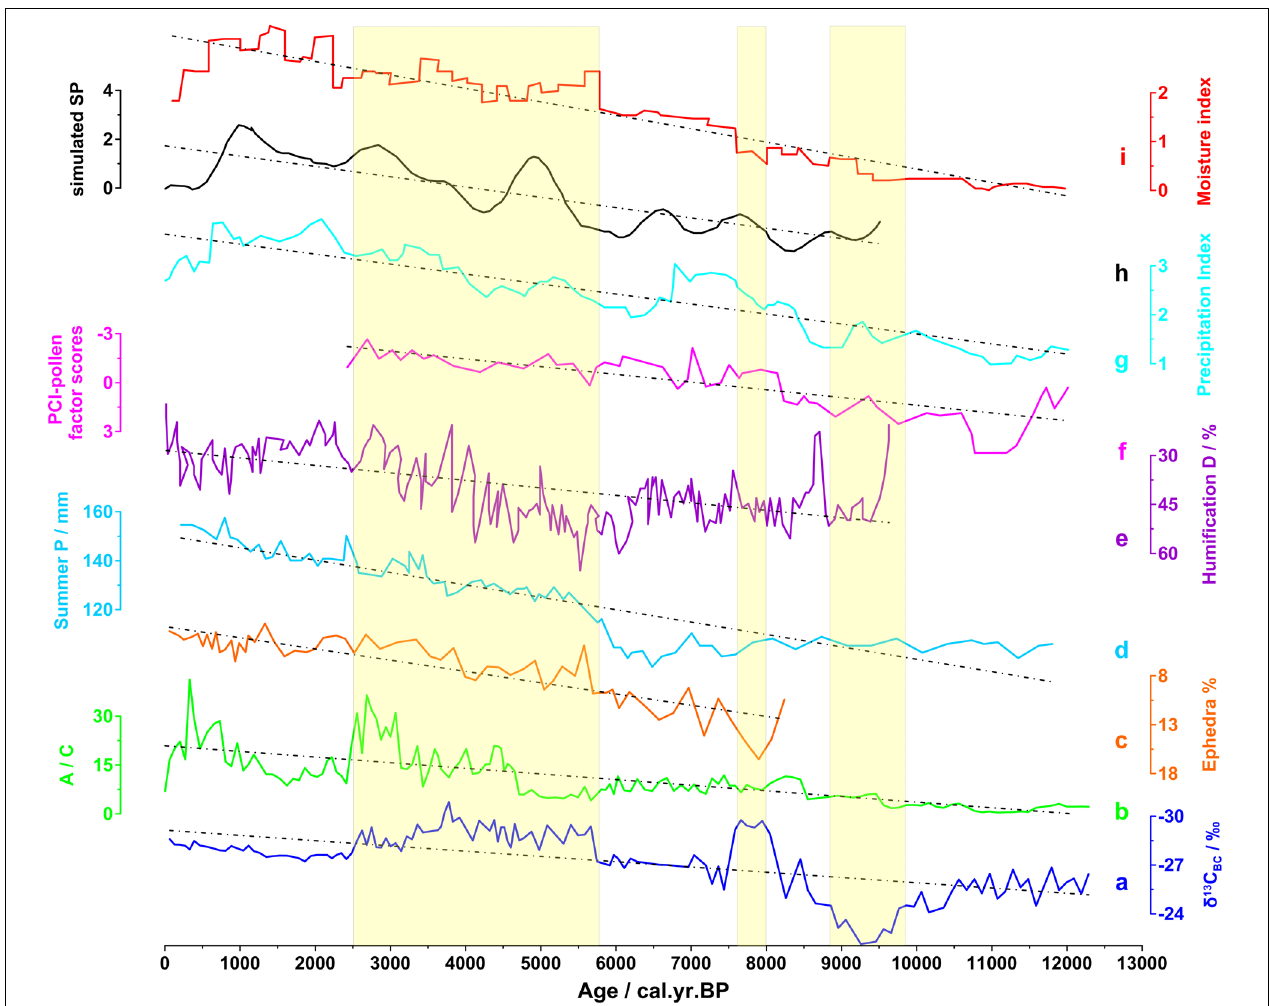
FIGURE 2 | Comparisons between a BC carbon isotope record of Sayram Lake (a) and other records from arid northwest China and the adjacent regions. (b) A/C Ratio of Sayram Lake (Jiang et al., 2013). (c) Ephedra% of Bosten Lake (Huang et al., 2009). (d) Summer precipitation reconstruction from Tianshan Mountains Loess (Xie et al., 2018). (e) Humification degree in Tielisha Peat (Zhang et al., 2016). (f) PC1-pollen factor scores of the Caspian Sea (Leroy et al., 2014). (g) Synthesized pollen-based Holocene precipitation-index from Altai Mountains and its adjacent areas (Zhang D. et al., 2018). (h) Simulated summer precipitation in arid central Asia (Zhang et al., 2017). (i) Synthesis moisture index from the Mongolian Plateau and its adjacent areas (Wang and Feng, 2013); Black dotted dash line represents proxies’ variation trend.